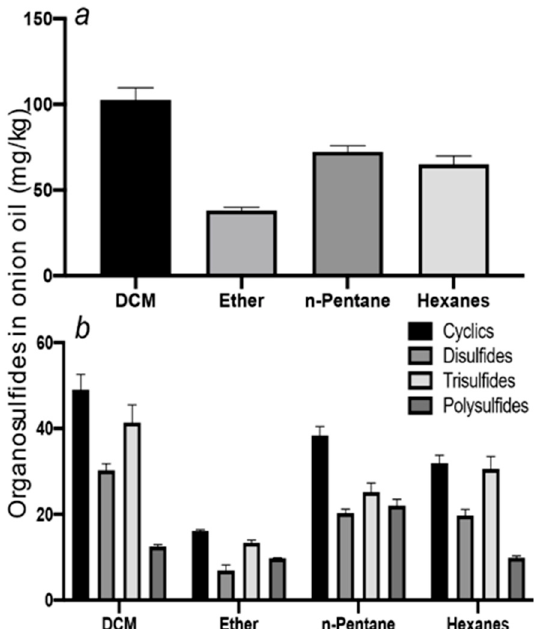
Figure 2. ( a ) Total amount of organosulfide obtained by solvent extraction, and ( b ) organosulfide structure type as a function of solvent used for extraction. Data are expressed as means ± SD. The difference among solvents in ( a ) were analyzed by Tukey’s test with a significance of p ≤ 0.05.